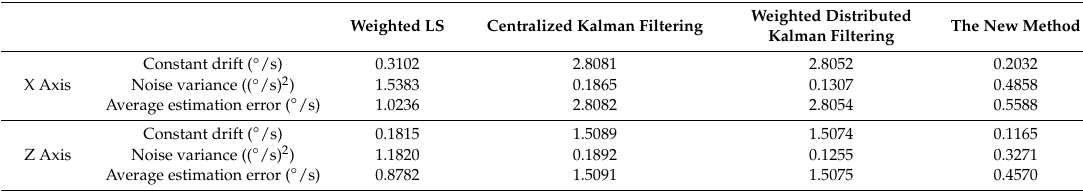
Table 4. The details of fusion signal error for the constant drift fault case.